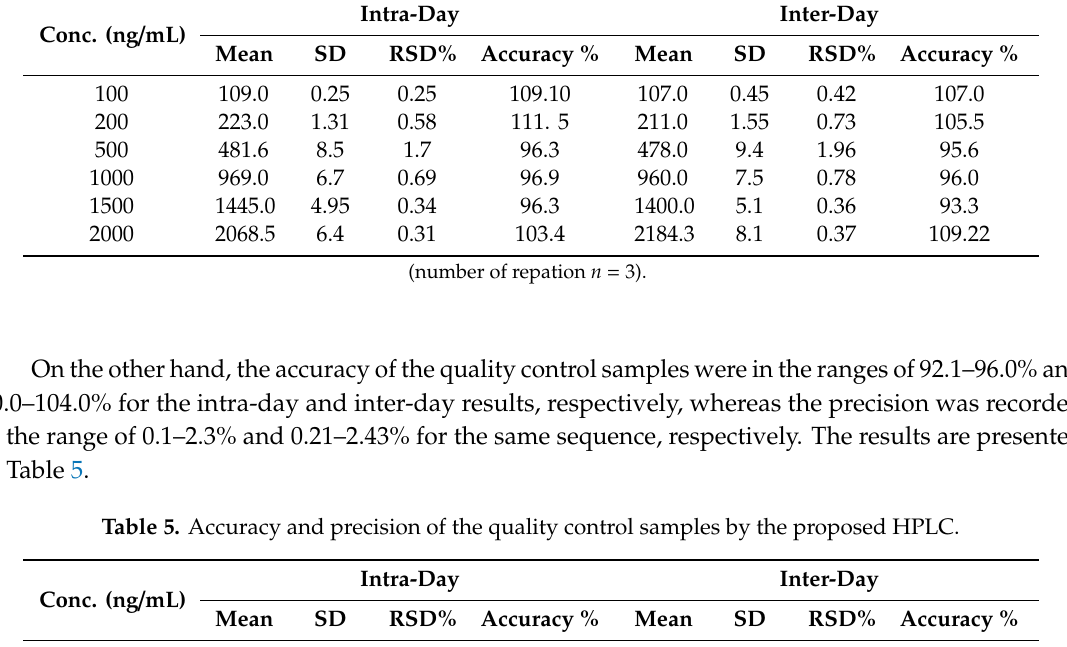
Table 4. Accuracy and precision of clonidine in spiked mice plasma using the proposed HPLC method. Intra-Day Conc. (ng / mL)